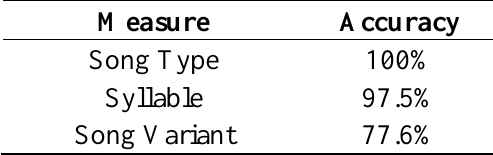
Table 3. Song type, syllable, and song variant classification accuracy for overall system.